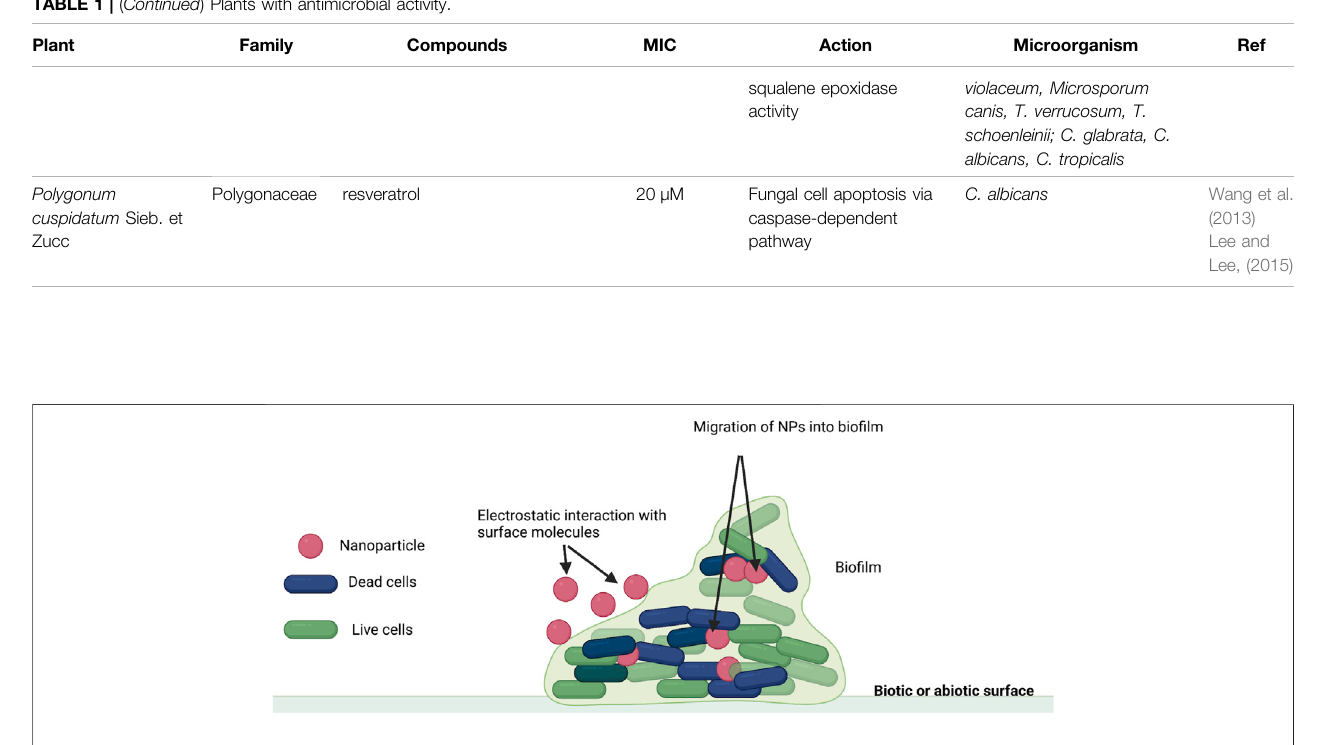
FIGURE 1 | Interaction between bio fi lm and NPs (Adapted from Shkodenko et al., 2020).